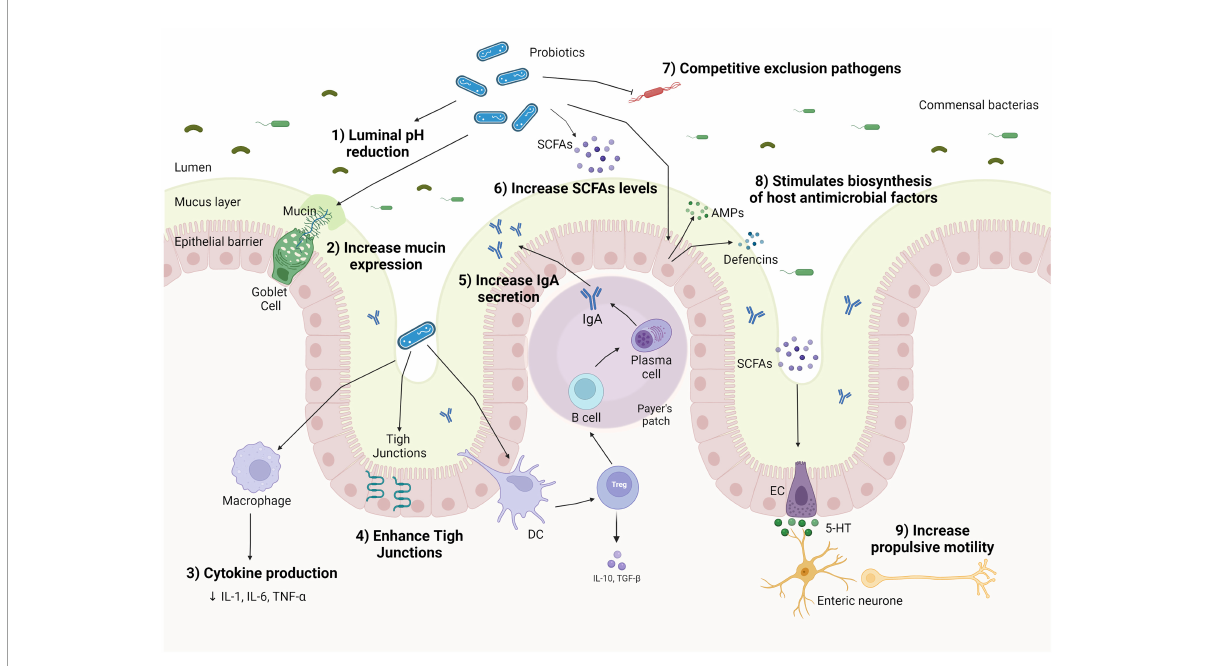
FIGURE1 Mechanisms of action of probiotics on the human gut in chronic constipation. Probiotics can decrease luminal pH (1); increase mucin production by goblet cells (2); shift macrophage cytokines production, lowering pro-inflammatory cytokines production (3); enhance tight junction protein expression, improve gut barrier function (4); increase Treg expression and stimulating IgA to enhance immunoglobulin A (IgA) secretion in Peyer’s patch (5); stimulate the proliferation of short-chain fatty acid (SCFA) bacterial producers (6); inhibit the colonization of pathogenic bacteria by competing for nutrients and location (7); enhance the secretion of antimicrobial peptides (AMPs), such as defensins and cathelicidins by epithelial cells via activation of the innate response, helping to eliminate commensals or pathogens that penetrate the mucus layer (8); and increase colonic motility through the conversion of tryptophan hydroxylase 1–5-hydroxytryptophan (5-HTP), which are converted to 5-hydroxytryptophan (5-HT) and released by enterochromaffin cells (ECs)